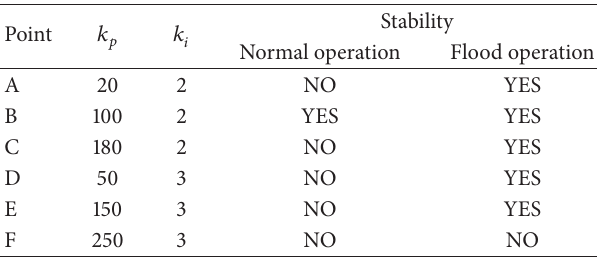
Table 3: Pairs of gains from the tuning